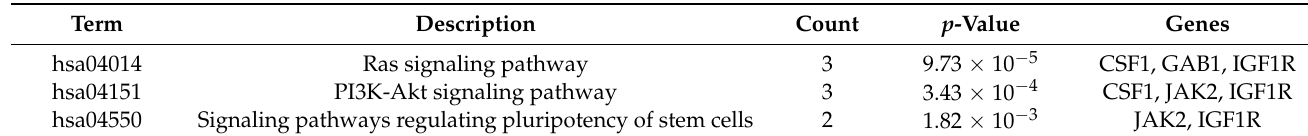
Table 2. The Kyoto Encyclopedia of Genes and Genomes (KEGG) pathway analysis of differentially expressed genes (DEGs).